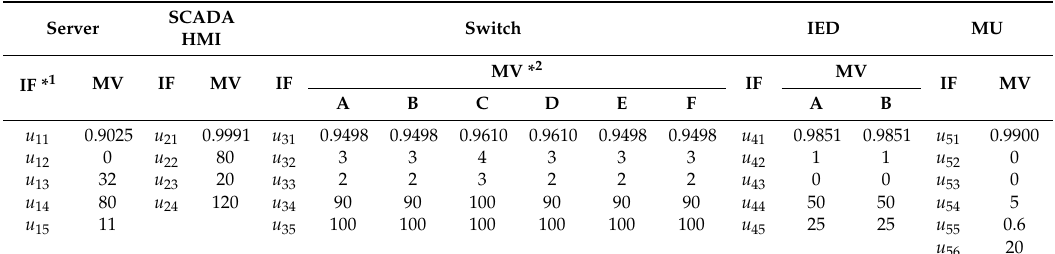
Table 25. Case 2 measured value of influencing factor of equipment.